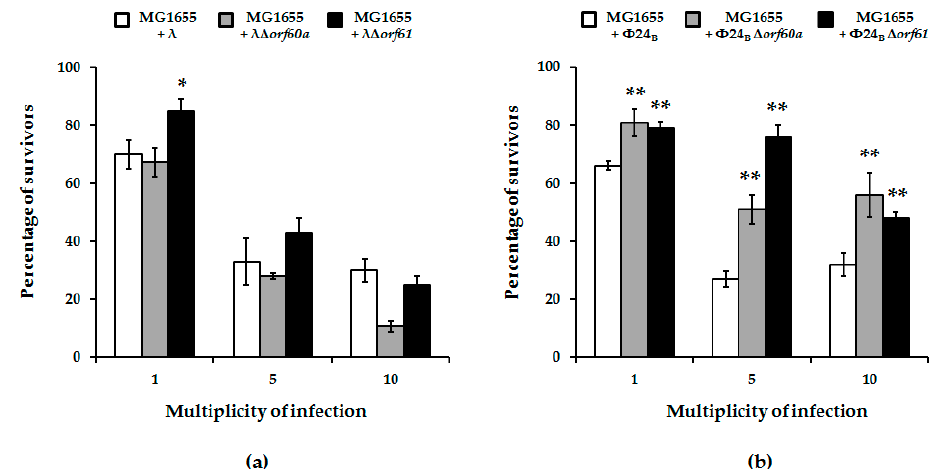
Figure 5. Percentage of survivors of E. coli MG1655 bacteria after infection of wild-type phages: λ (panel ( a ); white columns) and Φ 24 B (panel ( b ); white columns) or their deletion mutants: λ ∆ orf60a (panel ( a ); grey columns), λ ∆ orf61 (panel ( a ); black columns), Φ 24 B ∆ orf60a (panel ( b ); grey columns), and Φ 24 B ∆ orf61 (panel ( b ); black columns). Results are presented as mean values ± S.D. from three biological experiments. A t -test was performed for results from each multiplicity of infection (m.o.i.). The significance of differences between fractions of bacterial cells infected with wild-type phages and their deletion mutants are marked by asterisks, p < 0.05 (*) or p < 0.01 (**).